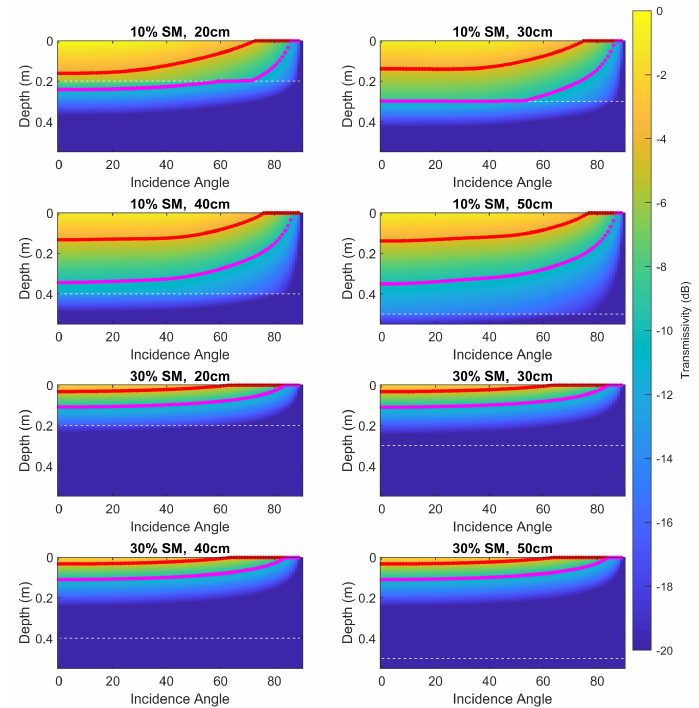
Figure 7. Incidence angle sweep of four two-layer profiles at 370 MHz. The white lines represent the location of the second layer, the red line represent the penetration depth of the configuration, and the magenta line depicts where the transmittance reaches 10% of its original energy. The upper slab SM is 10% for the upper four subplots and 30% for the lower four subplots. The second slab SM is 50% for all